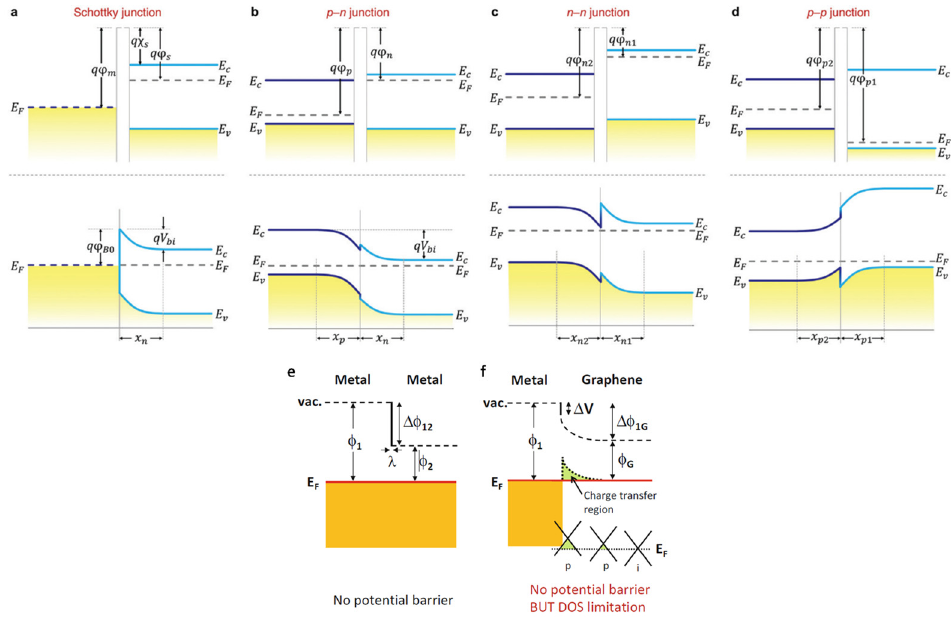
Figure 9. Different band alignment (before junction formation) and band bending (after junction formation) for different types of junctions. ( a ) Schottky junction. ( b ) p-n junction. ( c ) n-n junction. ( d ) p-p junction. Reproduced with permission from [54]. Copyright by The Royal Society of Chemistry (2019). ( e , f ) show the difference between metal–metal and metal–graphene contacting, with the latter presenting a charge transfer region responsible for the contact resistance. Adapted with permission from [100]. Copyright by Springer Nature (2015).